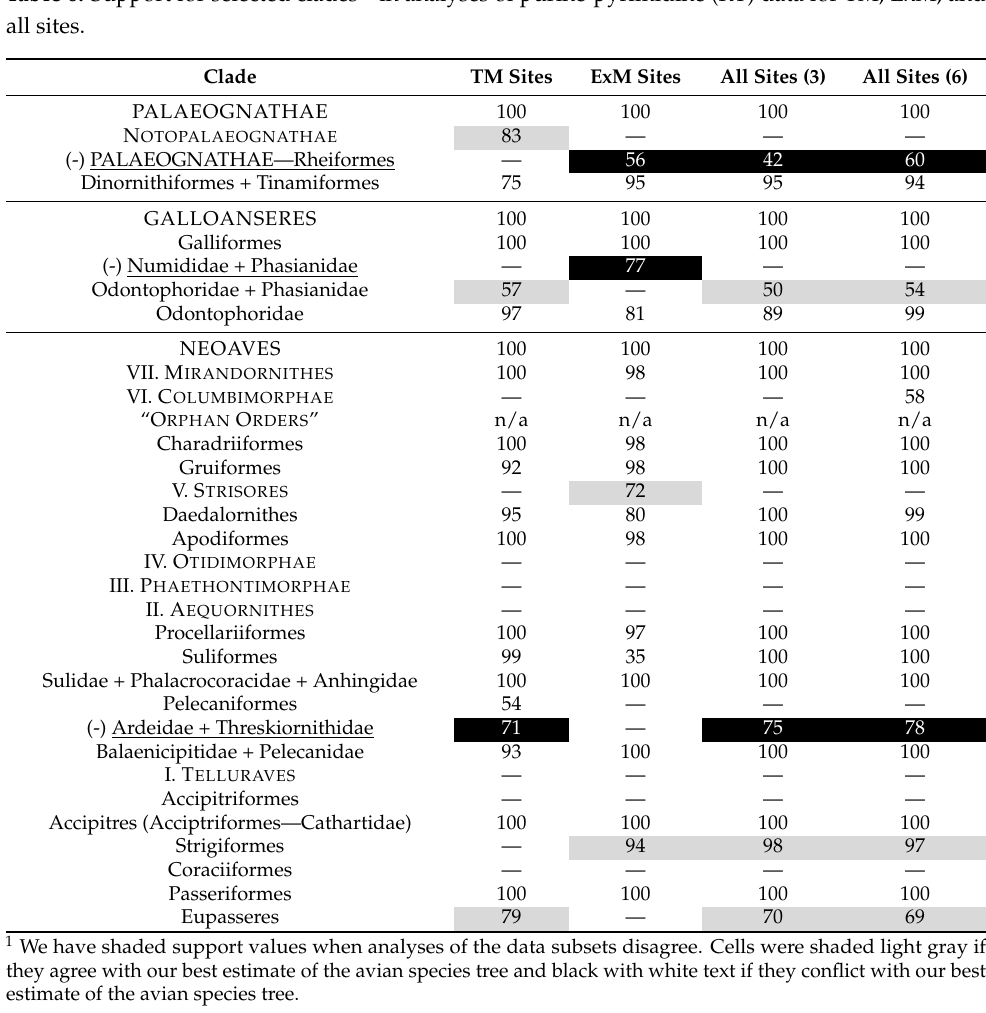
Table 6. Support for selected clades 1 in analyses of purine-pyrimidine (RY) data for TM, ExM, and all sites.